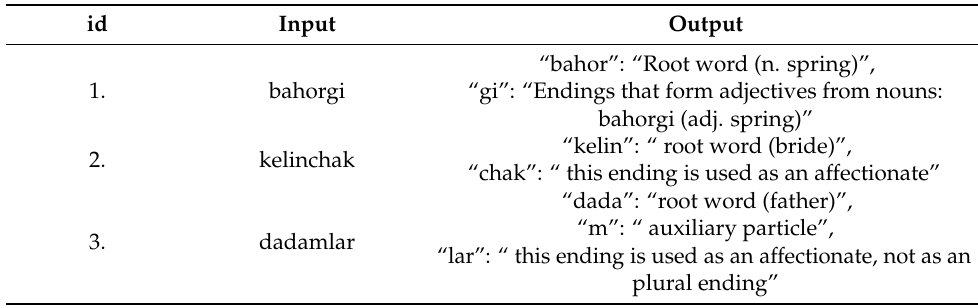
Table 14. Morphological analysis of words (words will not be stemmed, because they are stored in one of the exception word sets).